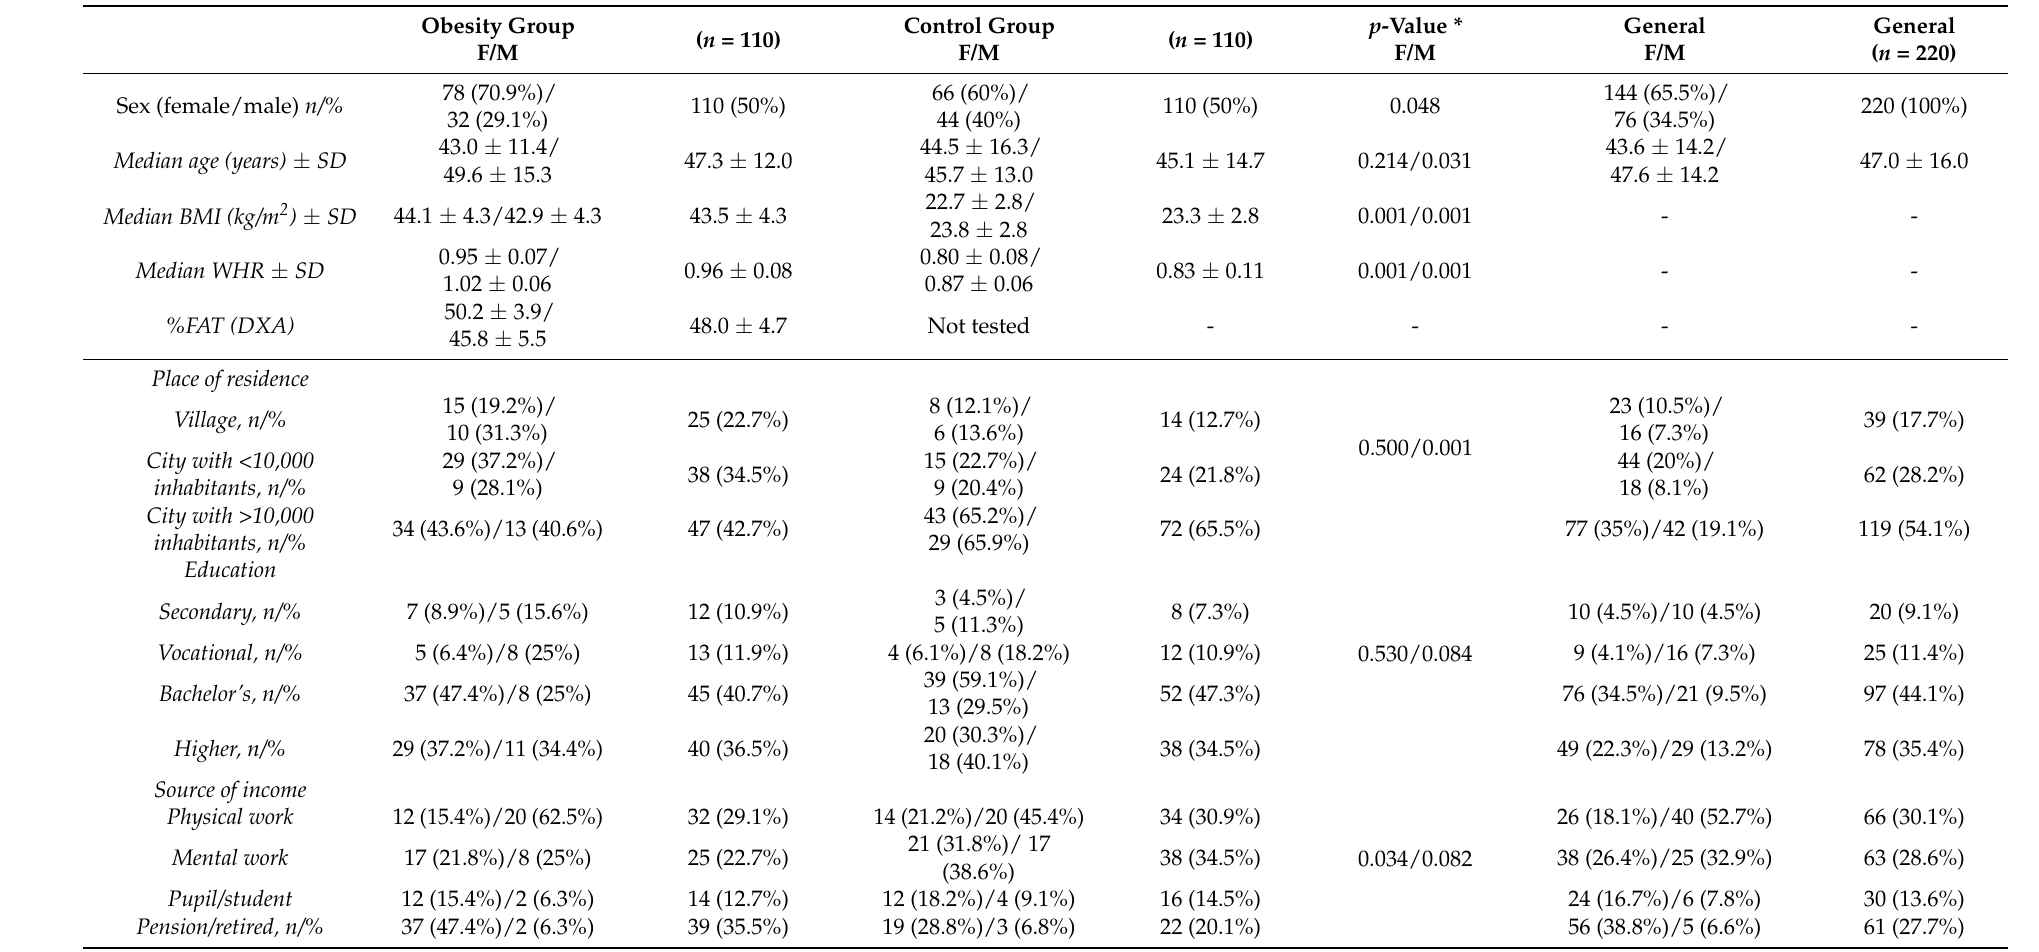
Table 1. Demographic data in the group of patients with a normal BMI and the group of obese